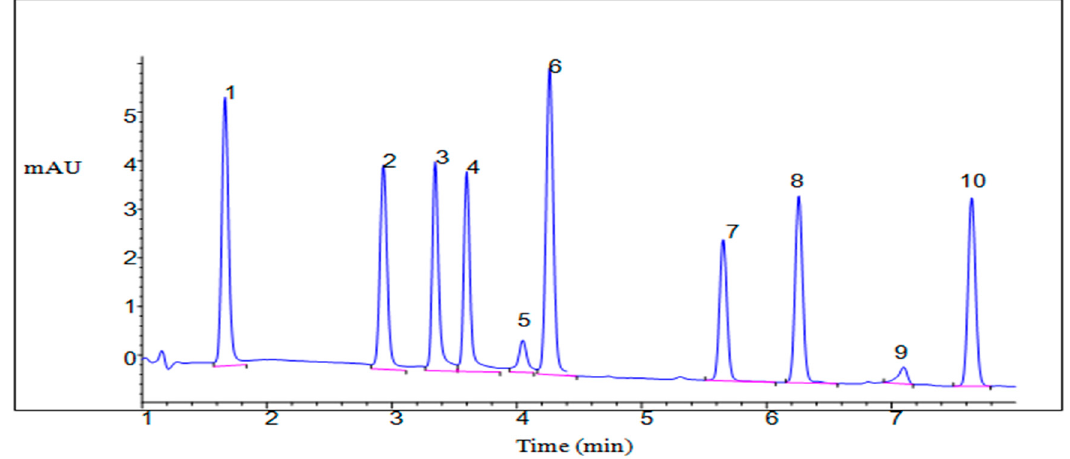
Figure 1. Chromatographic separation of 1 mg L − 1 standard mixture of ten multiclass antibiotic drugs (sulphanilamide, marbofloxacin, ciprofloxacin, danofloxacin, oxytetracycline, sulphadimethoxine, sulphacetamide, sulphamonomethoxine, sulphamethoxazole, tylosin, and sulphamerazine).